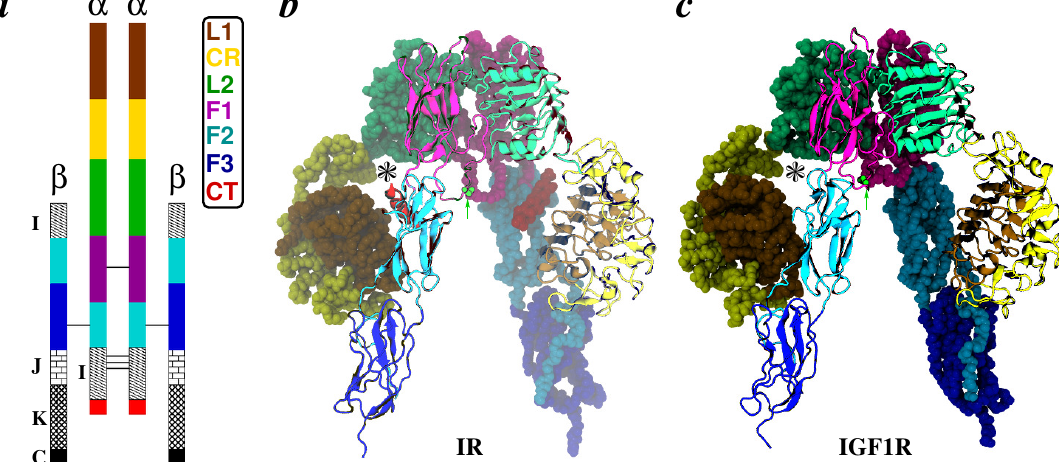
Figure 3. The domain organization and structures of receptor ectodomains. ( a ) A schematic of the domain organization in full-length receptors is shown. The α - and β -chains, as well as receptor domains are